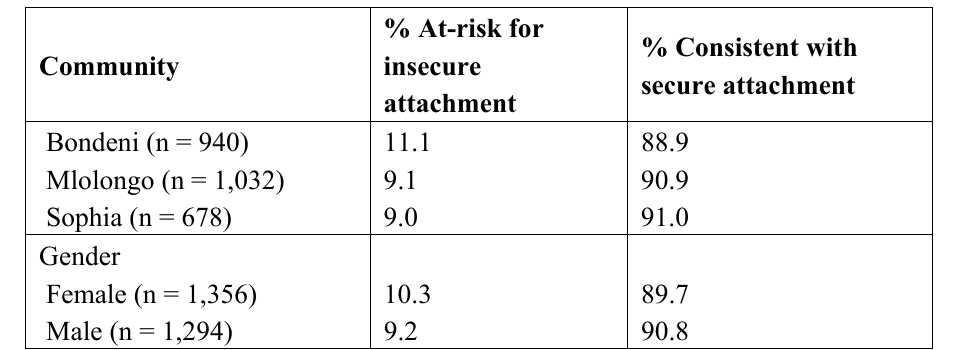
Table 1. Measures of, and associations with, attachment between caregivers and children <5 years of age at initial visit for three targeted communities,